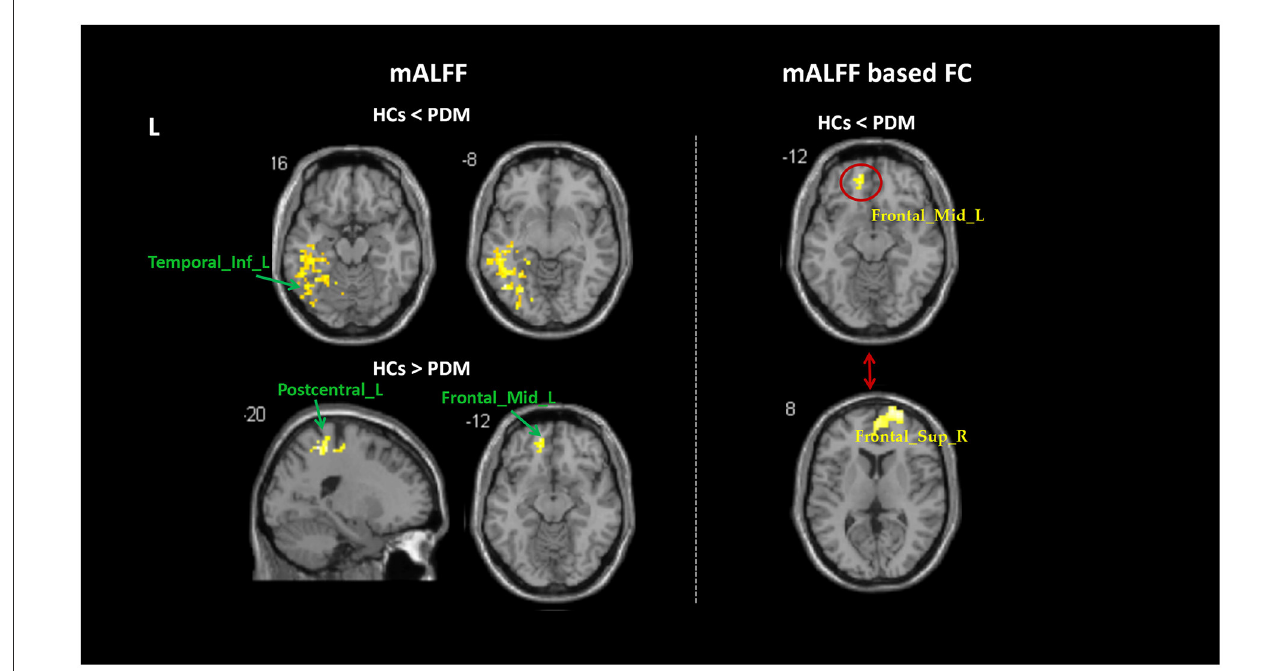
FIGURE2 Group differences in mALFF and mALFF-based FC between patients with PDM and HC (voxel threshold: uncorr. p < 0.001, cluster threshold: p -FWE < 0.05). Patients with PDM had significantly increased mALFF values in the left inferior temporal gyrus and decreased mALFF values in the left postcentral gyrus and middle frontal gyrus. Patients with PDM showed enhanced FC between the left middle frontal gyrus and the right superior frontal gyrus. PDM, patients with primary dysmenorrhea; HCs, healthy controls; FWE, family-wise error; mALFF, mean amplitude of low-frequency fluctuations.